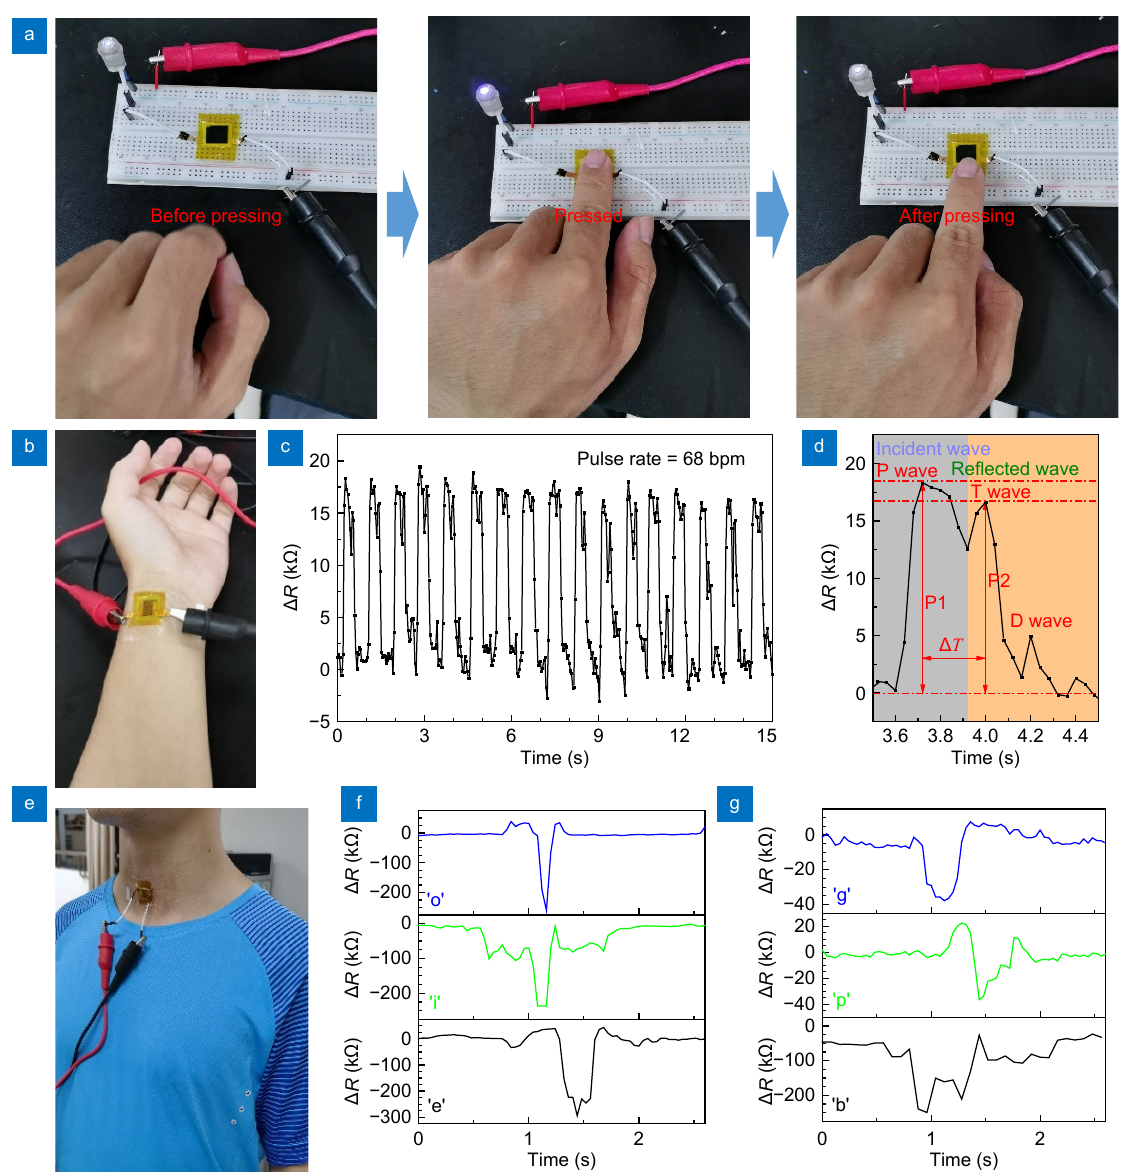
Fig. 9 | Applications of the flexible piezoresistive sensor. ( a ) LED brightness controlling. ( b ) Pulse detection. ( c ) Pulse wave detected from wrist. ( d ) Magnified wave from panel (c). ( e ) Voice recognition from vocal cords. ( f ) Waves of different vowels. ( g ) Waves of different